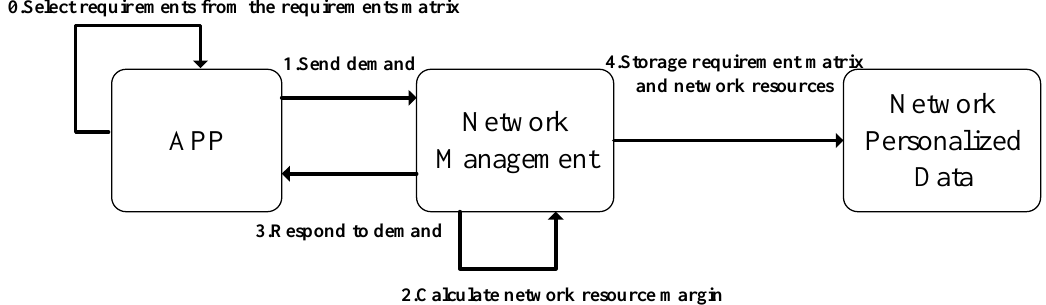
Figure 9. Apply for resources according to the recommended network configuration.